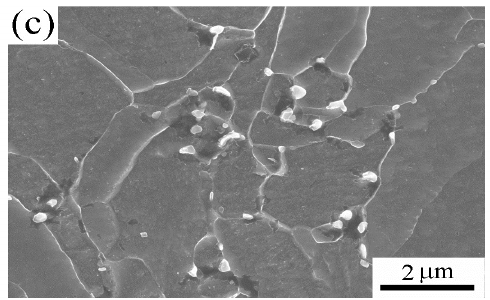
Figure 5. SEM micrographs for degenerate pearlite ( a ); intra ‐ granular ferrite nucleated around Ti ‐ oxide particle (insert: EDX result of Ti ‐ oxide particle) ( b ), and carbides ( c ) in specimens reheated at 990 °C; tempering at 550 °C ( a , b ) and 680 °C ( c ).